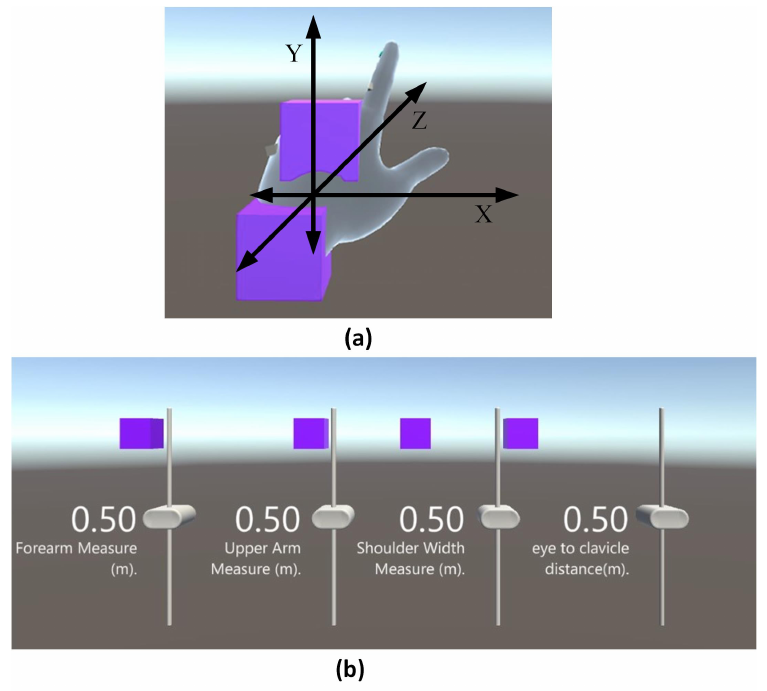
Figure 4. User interface (UI) for users to input upper arm joint information. ( a ) Game objects for reference on hand along with cardinal axes for the Unity environment ( b ) Interactable sliders for users to input body